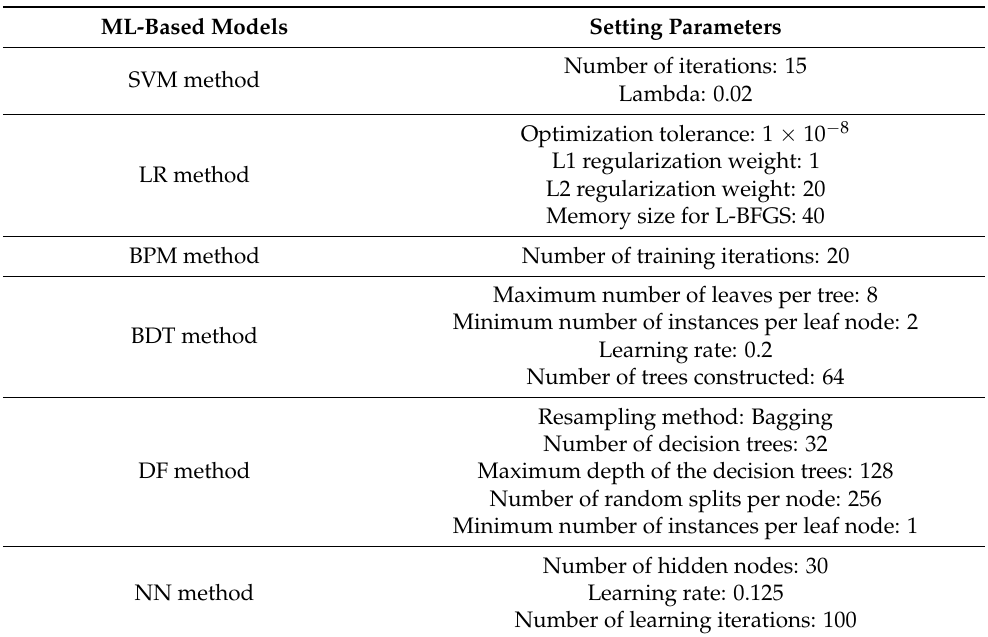
Table 2. The setting parameters and their values used in the Azure ML environment of the classifiers used in the multi- classification